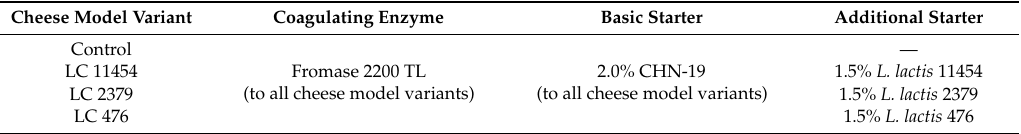
Table 1. Cheese model